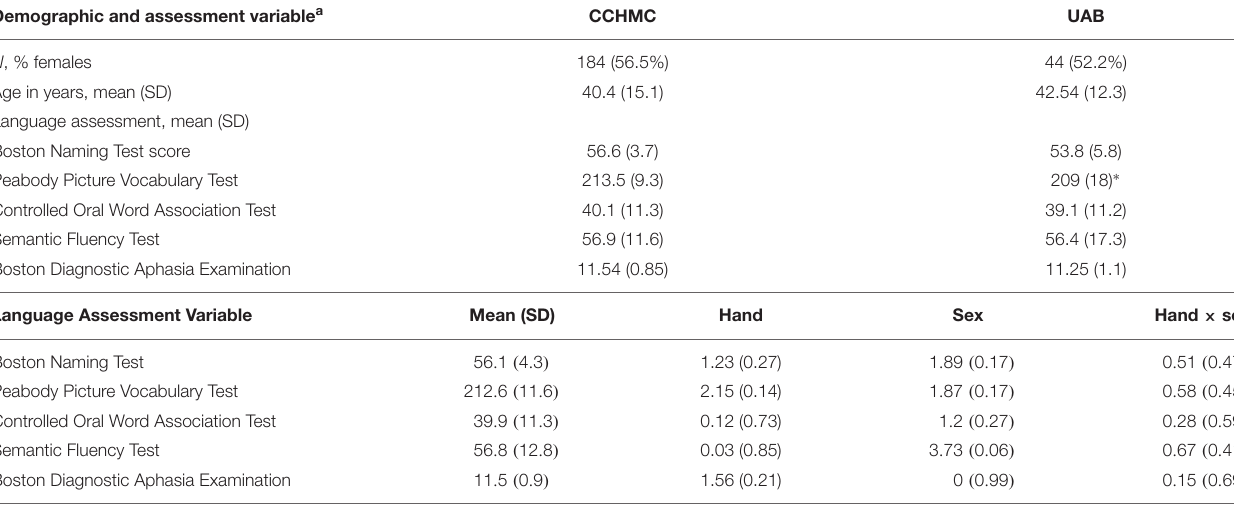
Demographic and assessment variable a